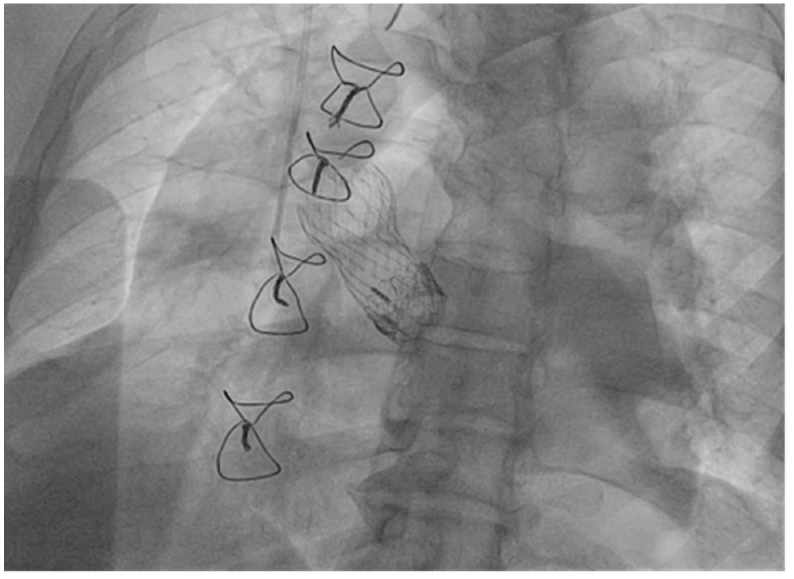
Figure 5. Left Anterior Oblique (LAO) view: Valve is deployed.